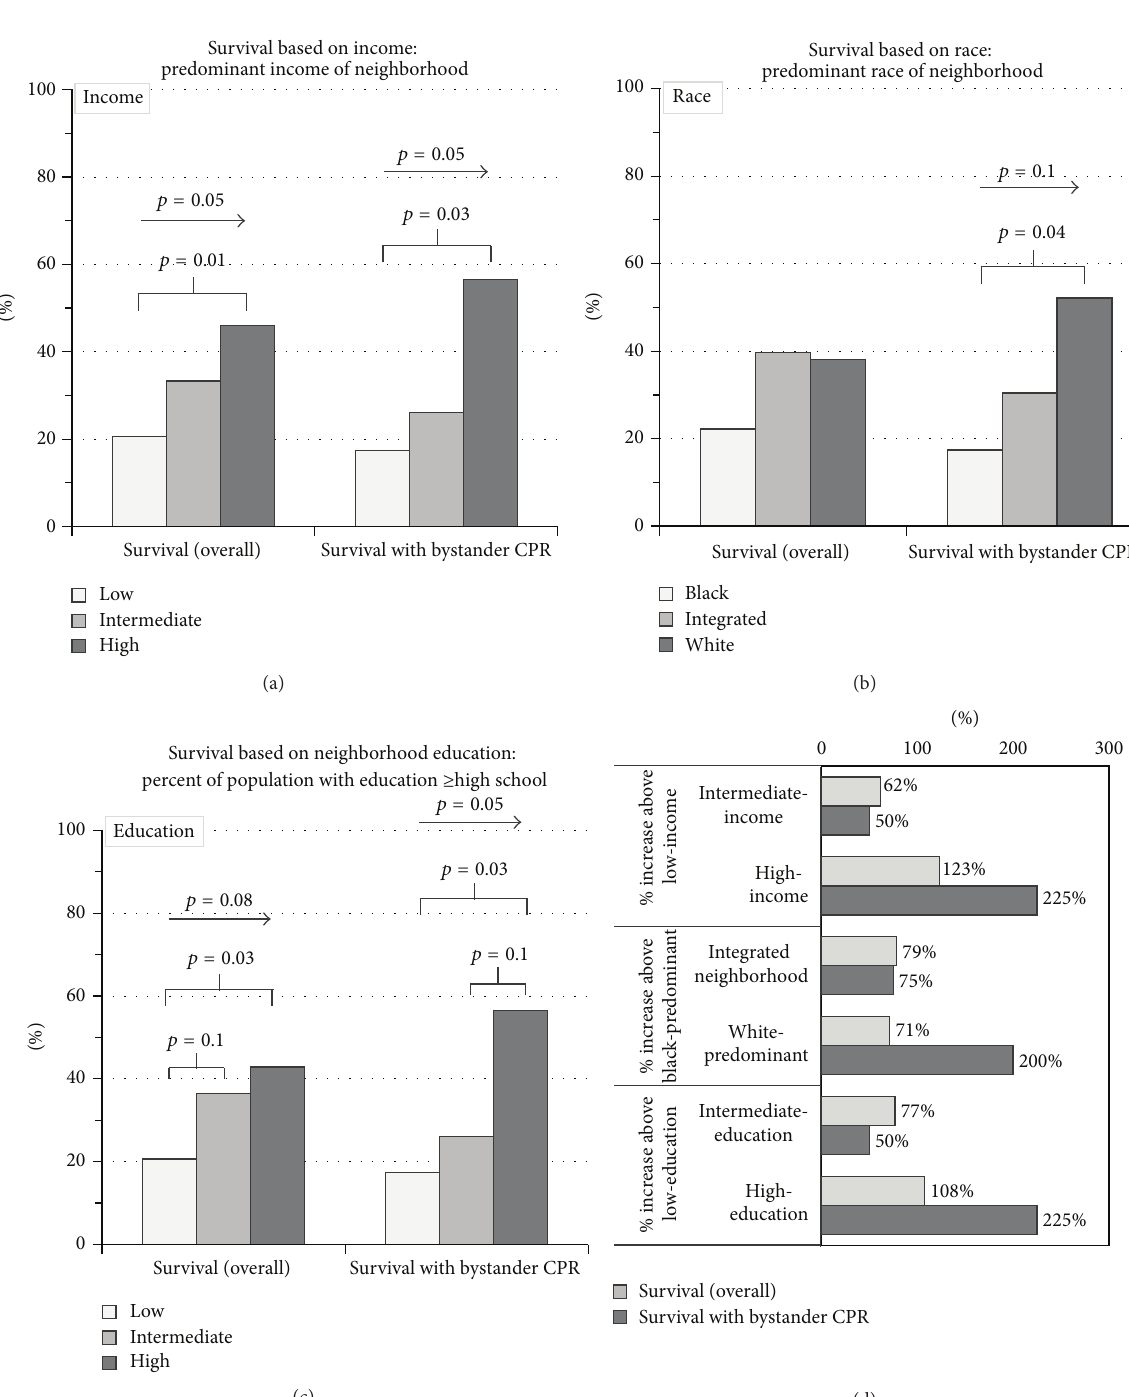
Figure 1: Survival based on income, race, and education level. Neighborhoods were separated by (a) income bracket, (b) race-predominance, and (c) education level. Overall survival (left) and survival with bystander CPR (right) are displayed. 𝑝 values with arrows indicate trends across the 3 groups. 𝑝 values with underlying brackets indicate differences between the two populations under each arm of the bracket. (d) Percent increased survival in intermediate-income and high-income versus low-income neighborhoods (upper half), integrated and white- predominant versus black-predominant neighborhoods (middle half), and high- and intermediate-education level versus low-education level (lower half) is